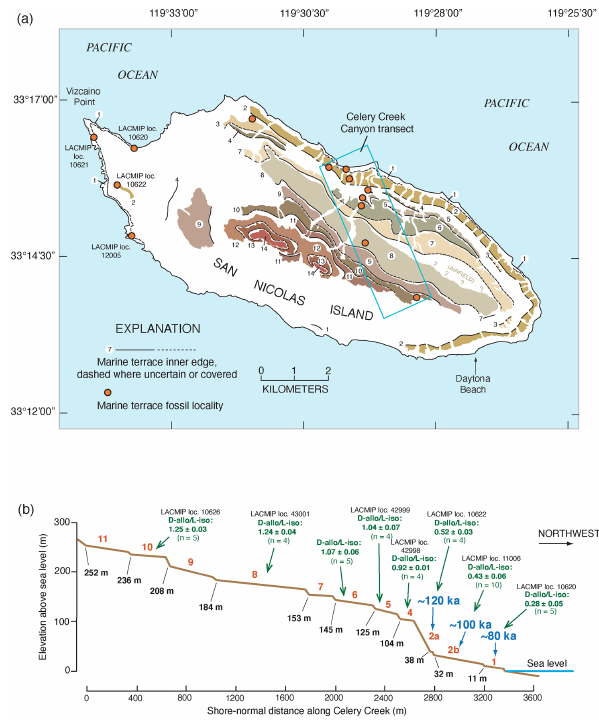
Figure 36. (a) Map of marine terraces on San Nicolas Island, Cal- ifornia (from Vedder and Norris, 1963; Muhs et al., 2012); orange dots are fossil localities. (b) Topographic profile across the low- est 11 terraces in the Celery Creek Canyon area (blue-boxed area in a ), showing terrace numbers, shoreline angle elevations (from Muhs et al., 2018), and (green lettering) ratios of the amino acids D-alloisoleucine to L-isoleucine in the fossil gastropod Tegula (data mostly from Muhs, 1985). Assuming a constant rate of uplift, ter- race 4 could be dated to ∼ 390ka ( ∼ MIS 11). Note that the large jump in elevation between terraces 2a and 4 is mirrored by a sub- stantial increase in amino acid ratios, indicating the likelihood that terraces representing MIS 9 ( ∼ 300ka) and MIS 7 ( ∼ 200ka) were removed by sea cliff retreat during MIS 5e.